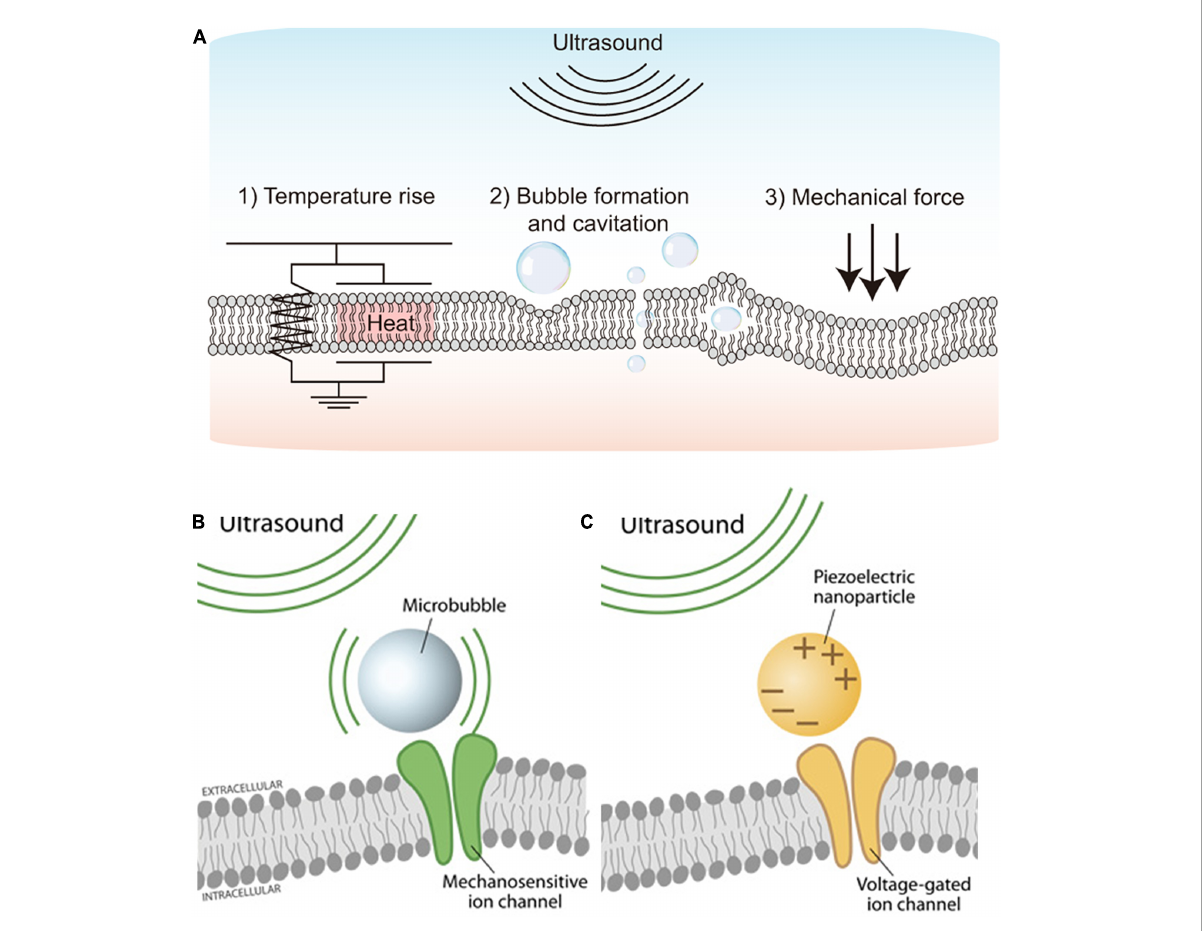
FIGURE1 Schematics showing the ultrasound stimulation mechanism and ultrasound stimulation methods. (A) Physical mechanisms of ultrasound-based excitation on neurons. Biophysical effects of ultrasound such as (1) Temperature rise, (2) Bubble formation and cavitation, and (3) Mechanical force. Adapted from Yoo et al. (2022). (B) Microbubble-assisted ultrasound stimulation of mechanosensitive channels. Adapted from Rivnay et al. (2017). (C) Piezoelectric nanoparticle-assisted ultrasound stimulation of voltage-sensitive ion channel. Adapted from Rivnay et al.